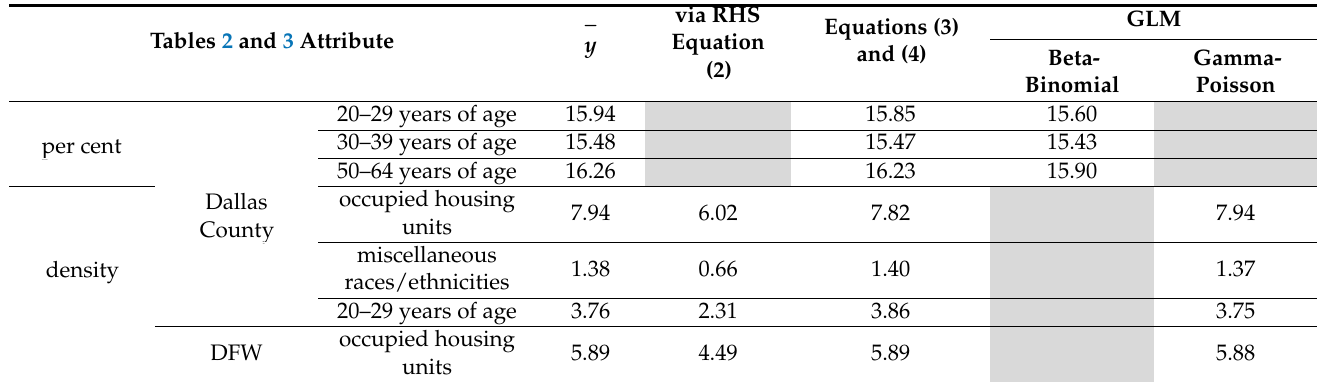
Table 6. Comparative GLM results for certain specimen attribute